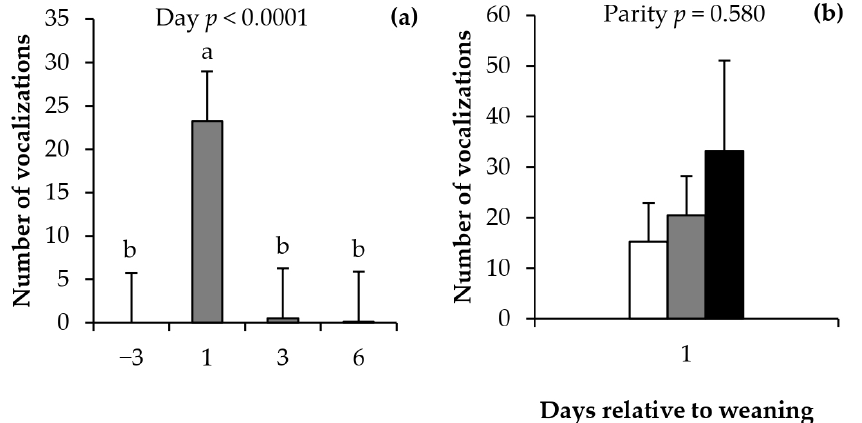
Figure 7. The number of vocalizations recorded in Nellore cows under grazing according to the days relative to weaning ( a ) and in primiparous (white), secundiparous (grey), and multiparous cows (black) on d +1 after weaning ( b ). Days with di ff erent superscripts di ff er from each other ( p < 0.05).